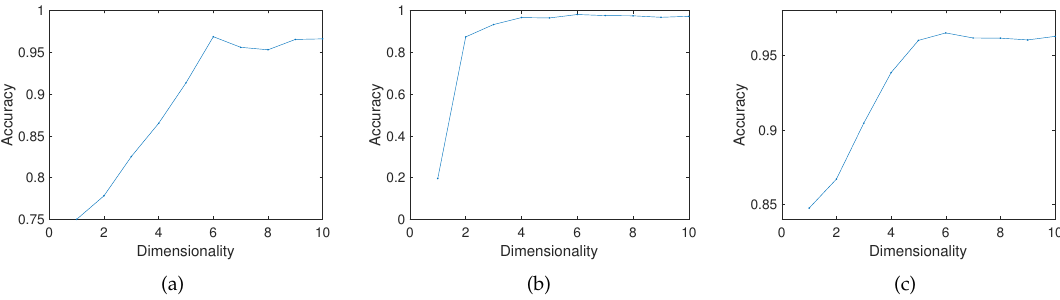
Figure 7. Classification accuracies of the proposed method with varying dimensionality ranging from 1 to 10 on three data sets. ( a ) the the Flevoland data set, ( b ) the Oberpfaffenhofen data set and ( c ) the San Francisco Bay data